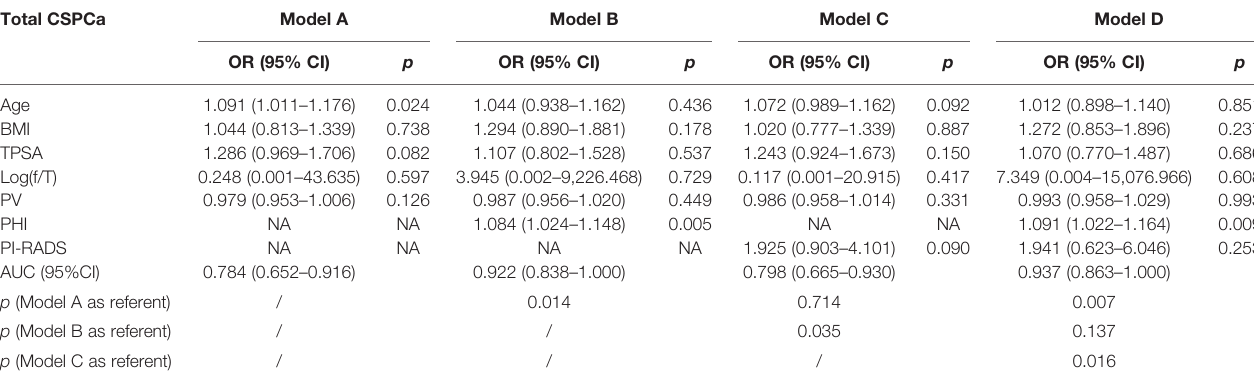
TABLE 4B | Multivariable analysis of the predictive value of the different models in the diagnosis of CSPCa in the PSA 10 – 20